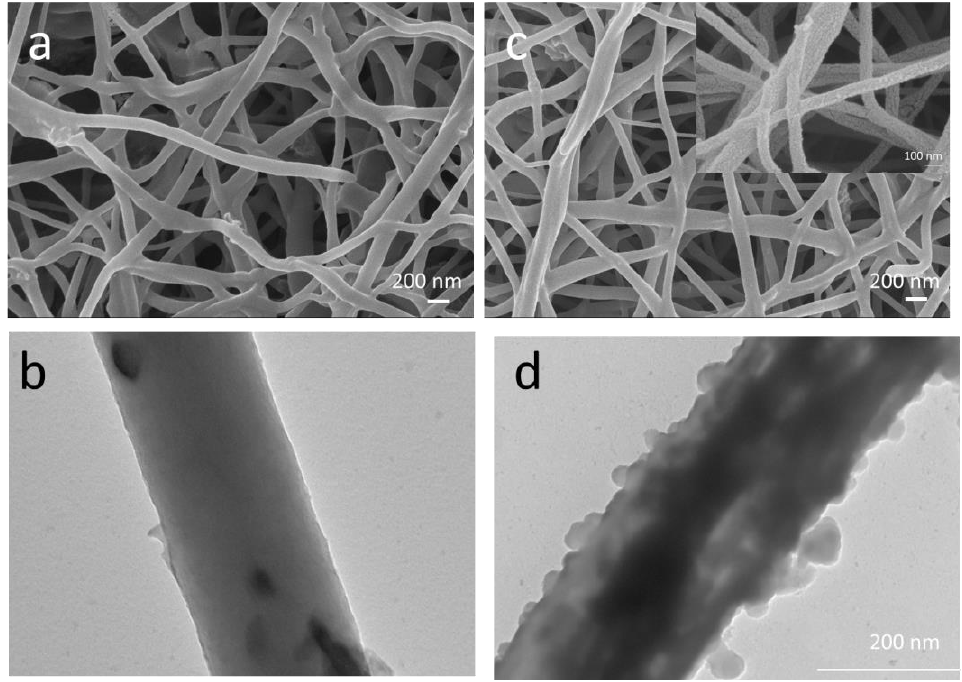
Figure 2. SEM and TEM images of the flexible Ge/CNFs ( a , b ) and MoS 2 @Ge/CNFs ( c , d ).